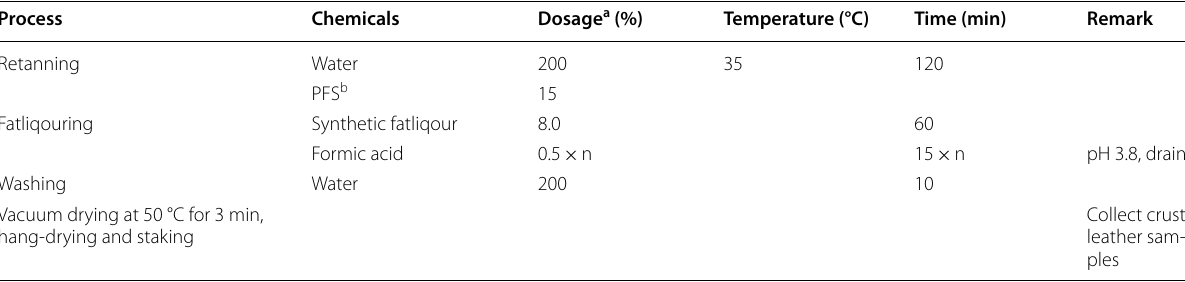
a The percentage of chemicals was based on the weight of shaved wet blue b The PFSs were the prepared PFS-18, PFS-33, PFS-50, PFS-63, and PFS-74, respectively (number presents